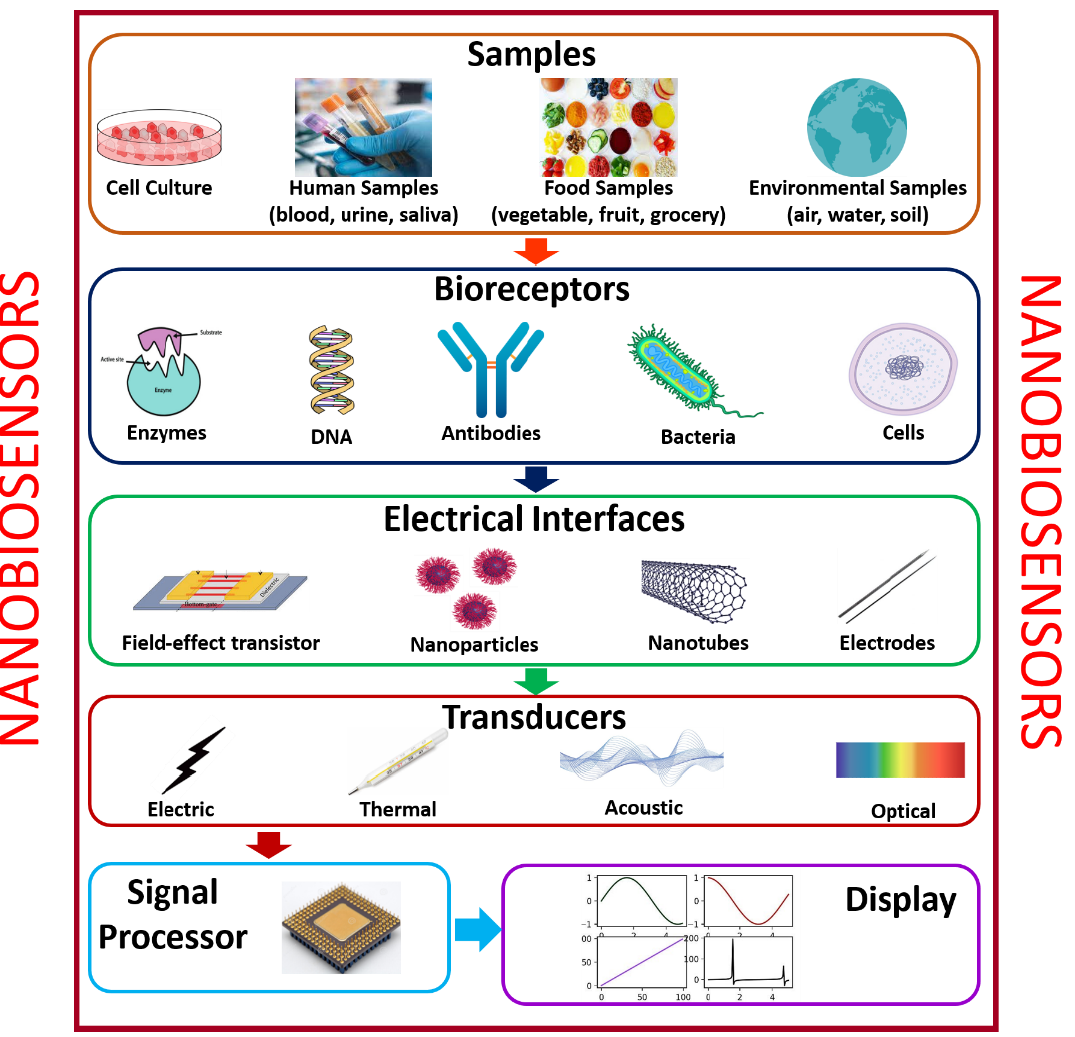
Figure 2. Various modules of typical biosensors.